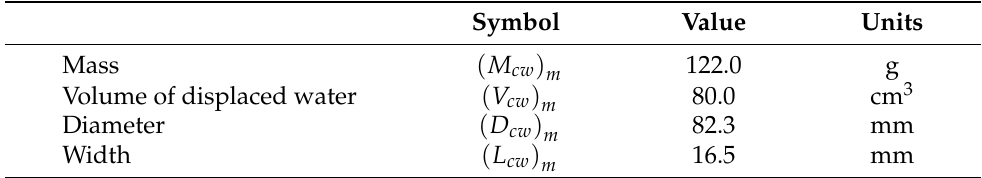
Table 3. Involved variables in the design of the scaled clumped weight.